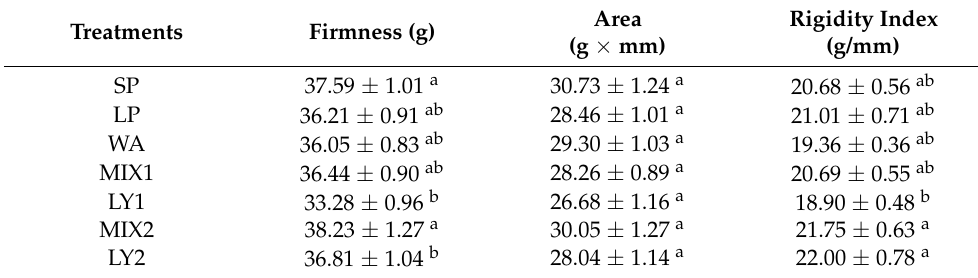
Table 5. Puncture test of final products. Different letters indicate significant differences among the treatment ( p ≤ 0.05). Data are average from three replicates ± standard error.